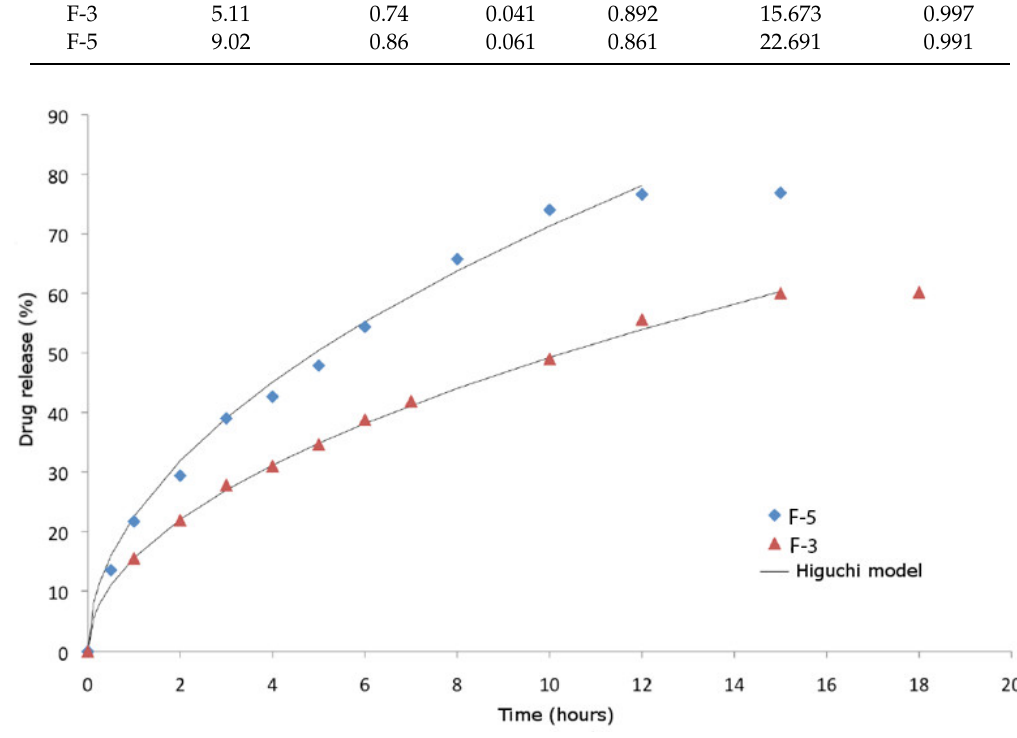
Figure 6. Time-course monitoring of drug release for F-5 and F-3 formulations. Table 4. Regression coefficients and kinetic constants for various release models.